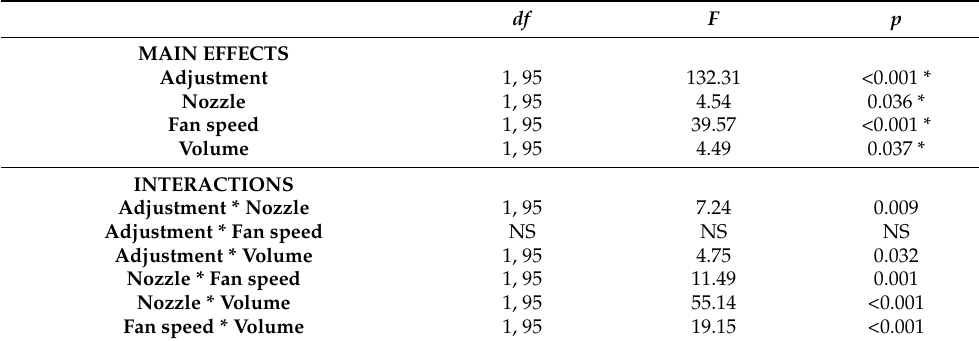
Table 5. Two-way ANOVA results for the normalized volume collected in the canopy zone with the T sprayer (least significant difference (LSD) test, p < 0.05) a .